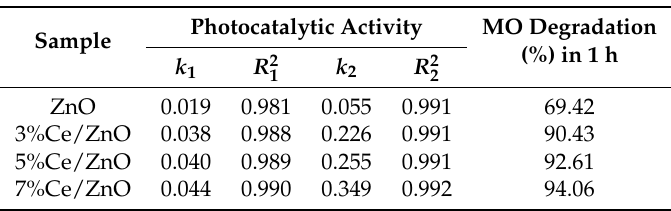
Figure 7. Change in absorption spectra of the ( a ) pristine ZnO, ( b ) 3% Ce/ZnO, ( c ) 5% Ce/ZnO, and ( d ) 7% Ce/ZnO catalysts during photodegradation of methyl orange. Table 2. Summary of the first- and second-order kinetic adsorption rate constants and correlation coefficients of photocatalytic degradation of methyl orange based on the pristine ZnO and Ce/ZnO